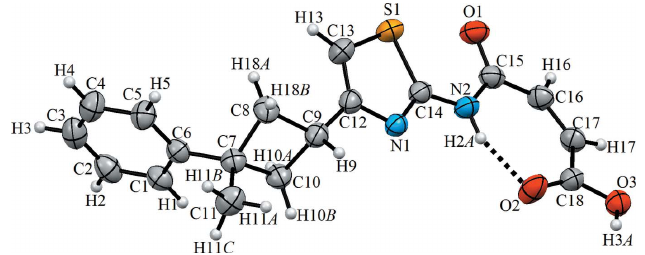
Figure 2 A view of the crystal packing of the title compound. Blue dashed lines denote the intermolecular O3—H3 A (cid:2)(cid:2)(cid:2) N1 hydrogen bonds forming a C 1 (9) motif (Table 1). (7) ring 1 1